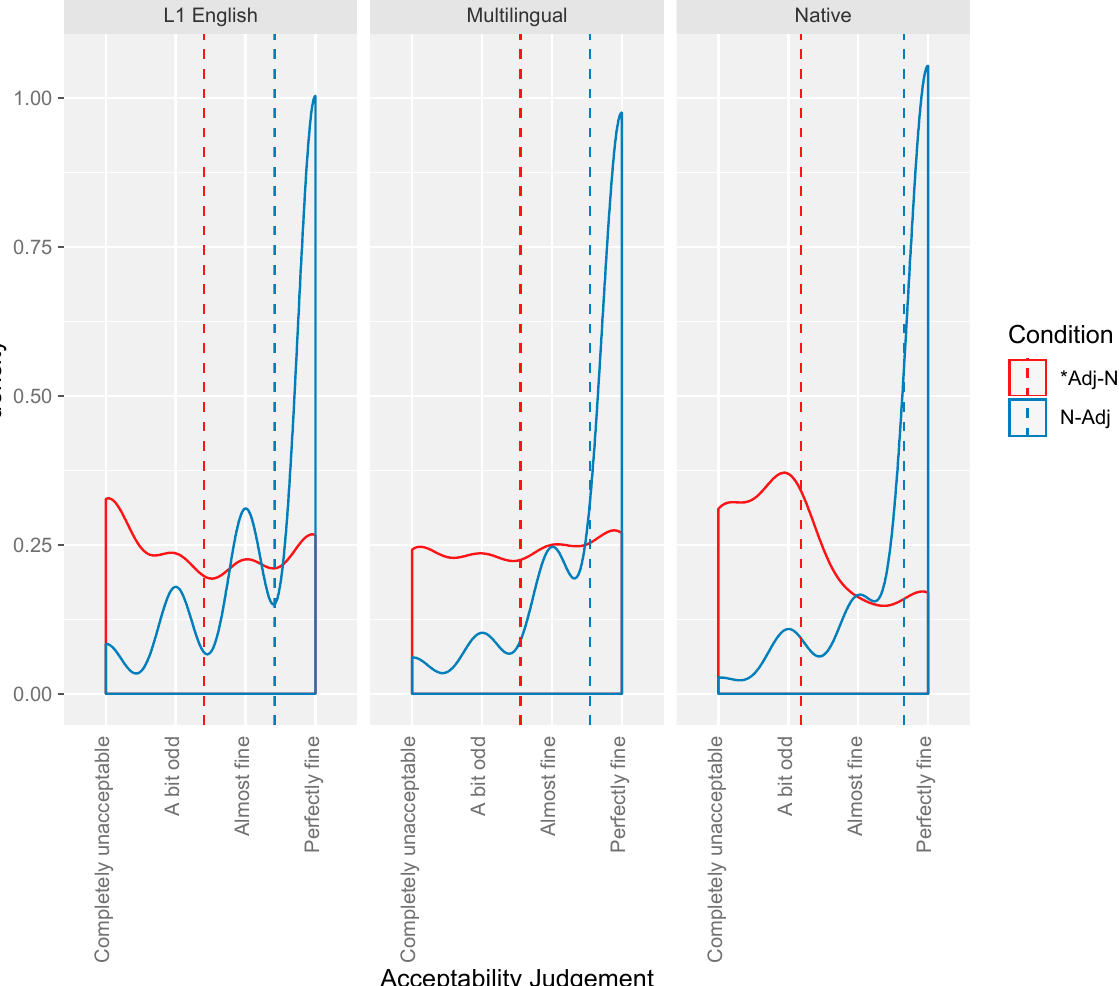
Figure 3. Density plot of acceptability judgements for pre- and post-nominal relational adjectives (*Adj–N/ N–Adj) given speaker group (L1 English, Multilingual, Native).